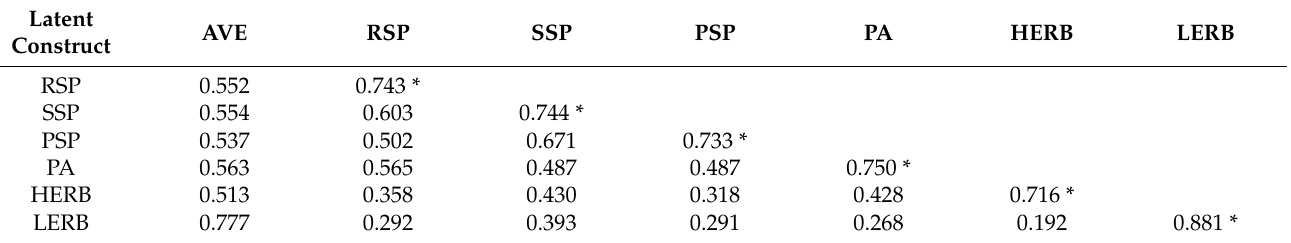
Table 4. Results of discriminant validity